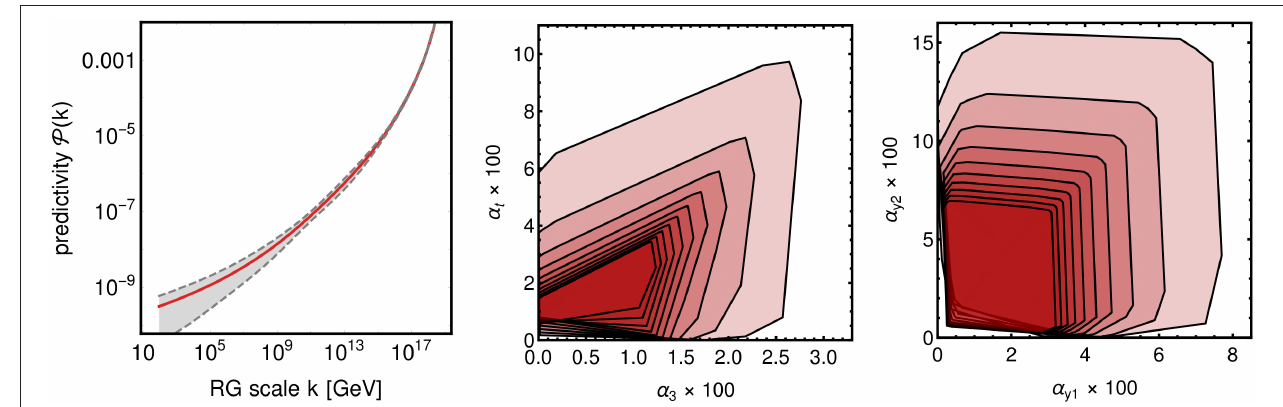
FIGURE 5 | In the left panel we show the predictivity of the BSM model identified in Equation (16), averaged over 10 sets of perturbative but otherwise random initial EFTs. The gray-dashed region indicates the statistical error. The other two panels show projections of the evolving theory-space volume [onto the α 3 - α t -plane (middle) and onto the α R 1 y - α R 2 y -plane (right)]. We plot its convex hull at each order of magnitude below 3 Planck with increasingly darker-red shading toward the IR.